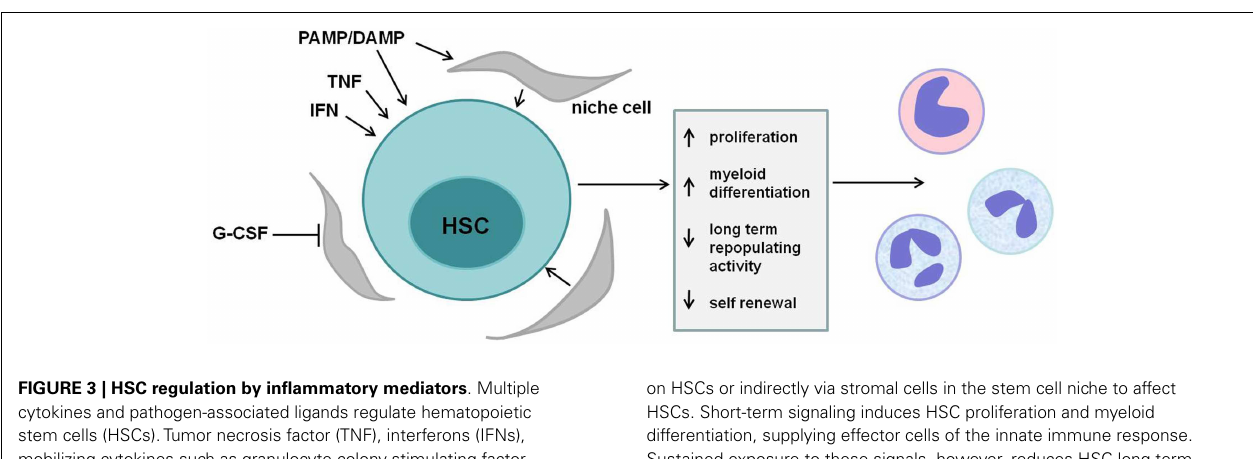
FIGURE 3 | HSC regulation by inflammatory mediators . Multiple cytokines and pathogen-associated ligands regulate hematopoietic stem cells (HSCs).Tumor necrosis factor (TNF), interferons (IFNs), mobilizing cytokines such as granulocyte colony-stimulating factor (G-CSF), and various pathogen- and danger-associated molecular patterns (PAMPs/DAMPs) act either directly via their cognate receptors